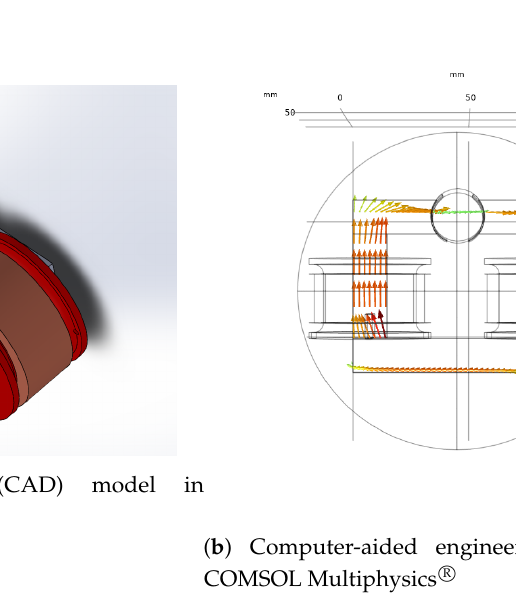
Figure 6. Magnetic